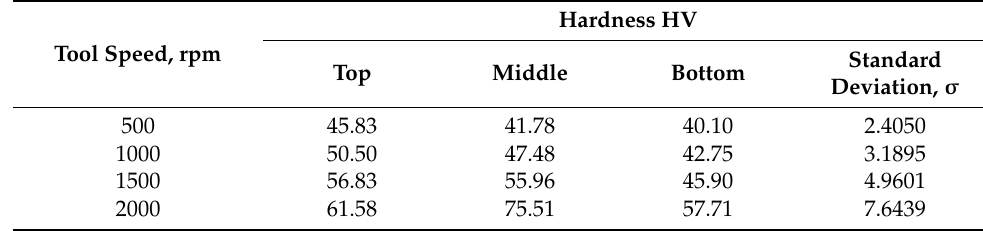
Table 6. Effect of different speed values on hardness.